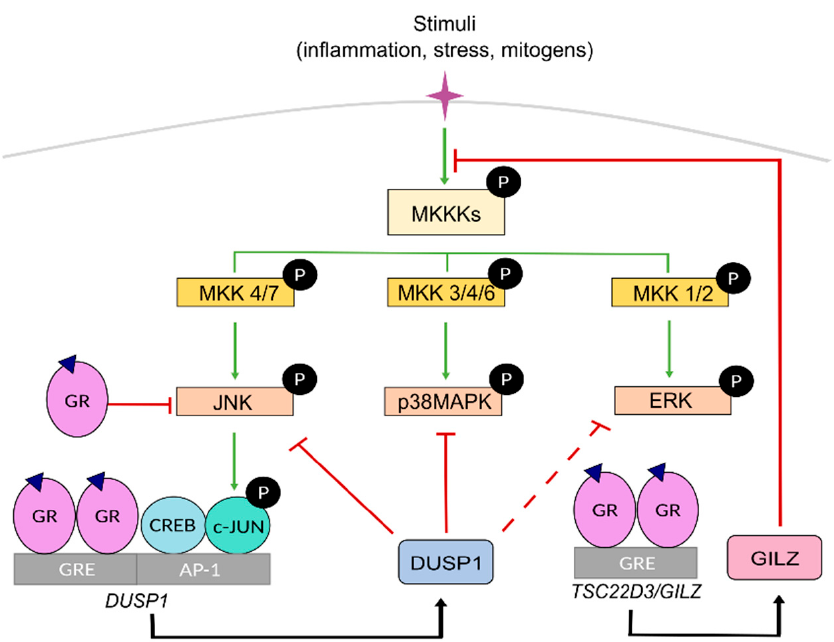
Figure 2. Mitogen-activated protein kinase (MAPK) signaling cascades and their inhibition by GR. MAPKs connect extracellular signaling with modulation of gene expression. In response to diverse stimuli, the kinases participating in the MAPK cascade phosphorylate and activate downstream kinases or other substrates including transcription factors. MAPK kinase kinases kinases (MKKKs) act on MAPK kinase kinases (MKKs) that specifically phosphorylate members of the MAPK JNK, p38, and ERK subfamilies which then signal downstream to regulate transcription of target genes dependent on AP-1 dimers (CREB/c-JUN) bound to AP-1 response elements. Ligand-bound GR negatively regulates MAPKs either by direct interference, as shown for JNK, or by regulating the expression of anti-inflammatory genes such as the MAPK phosphatase DUSP1 or Glucocorticoid- induced leucine zipper ( GILZ/TSC22D3 ). GILZ can also interact with proteins of the MAPK cascade to inhibit downstream activation of MKK1/2 and ERK. Green arrows and red blunt-ended lines indicate induction and inhibition, respectively. Dotted lines mark attenuated inhibition. Black arrows refer to the proteins encoded by GC-activated GR transcriptional targets DUSP1 and TSC22D3/GILZ . GR can inhibit MAPK function through direct and indirect mechanisms [51–56].